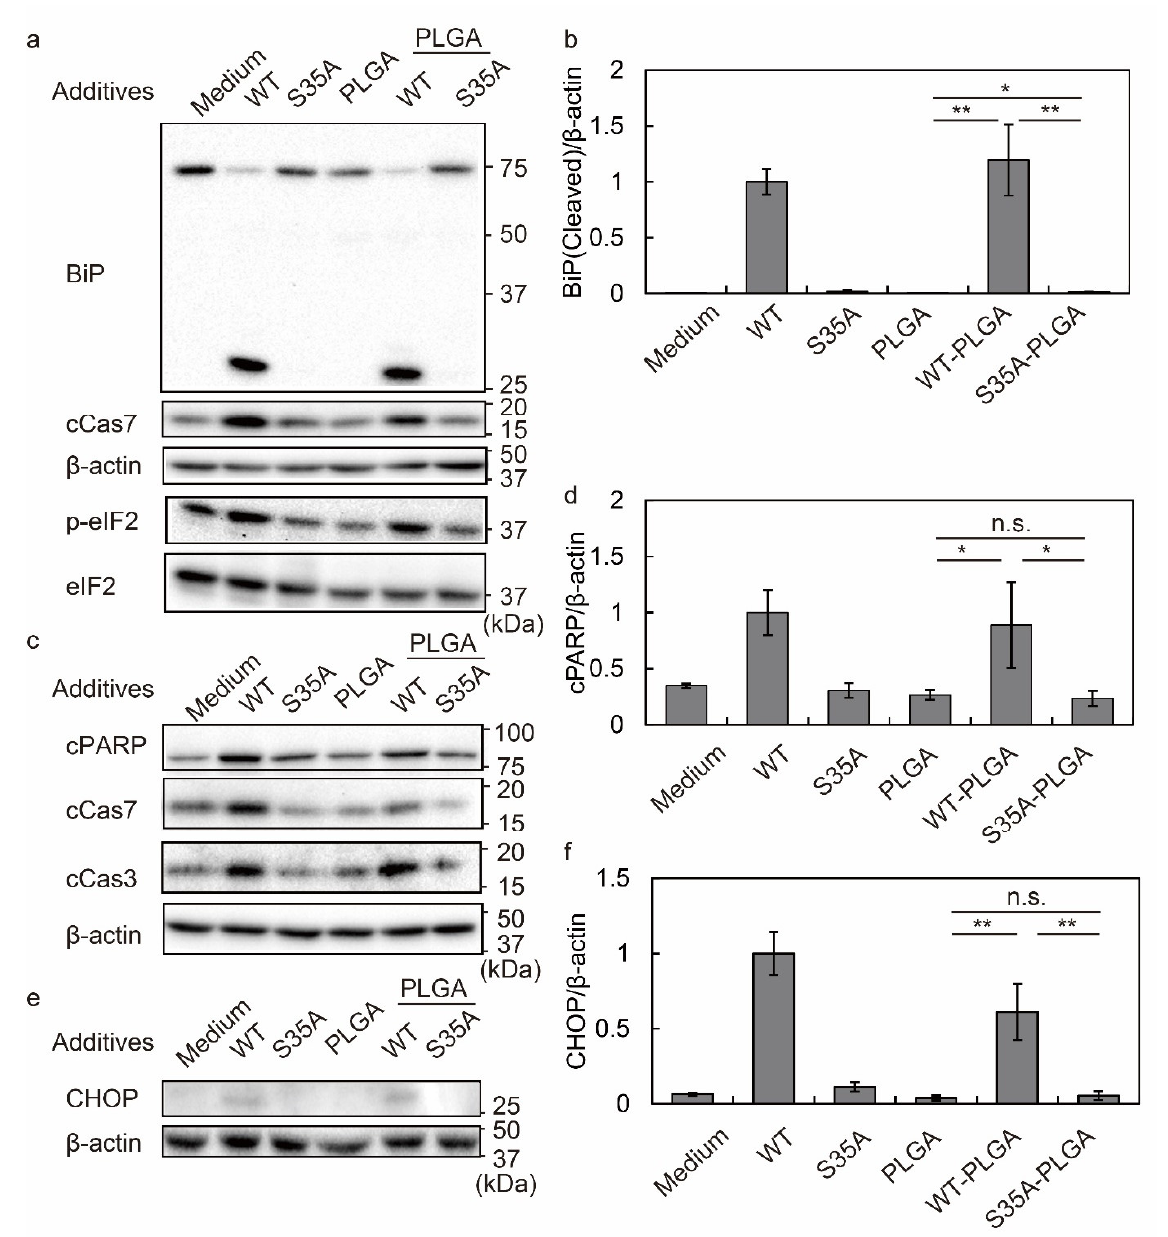
Figure 4. Induction of ER stress and cytotoxicity by SubAB-PLGA NPs in HeLa cells. ( a – f ) HeLa cells were treated with or without 5 μg/mL toxins and 20 μg/mL toxin-PLGA NPs for 3, 8, and 20 h. After treatment, the cells were lysed in SDS sample buffer and subjected to Western blotting. cCas7, cleaved caspase 7; cCas3, cleaved caspase 3; cPARP, cleaved PARP. ( a ) Evaluation of BiP cleavage, caspase 7 activation, and eIF2 phosphorylation at 3 h. ( b ) Quantification of BiP cleavage by densitometry. ( c ) Evaluation of PARP cleavage, and caspase 3 and 7 activation at 8 h. ( d ) Quantification of PARP cleavage by densitometry. ( e ) Evaluation of CHOP expression at 20 h. ( f ) Quantification of CHOP expression by densitometry. Data are expressed as means ± S.D. ( n = 3). Statistical analyses were performed using Student’s t -test. n.s., not significant. * p < 0.05, ** p < 0.01.